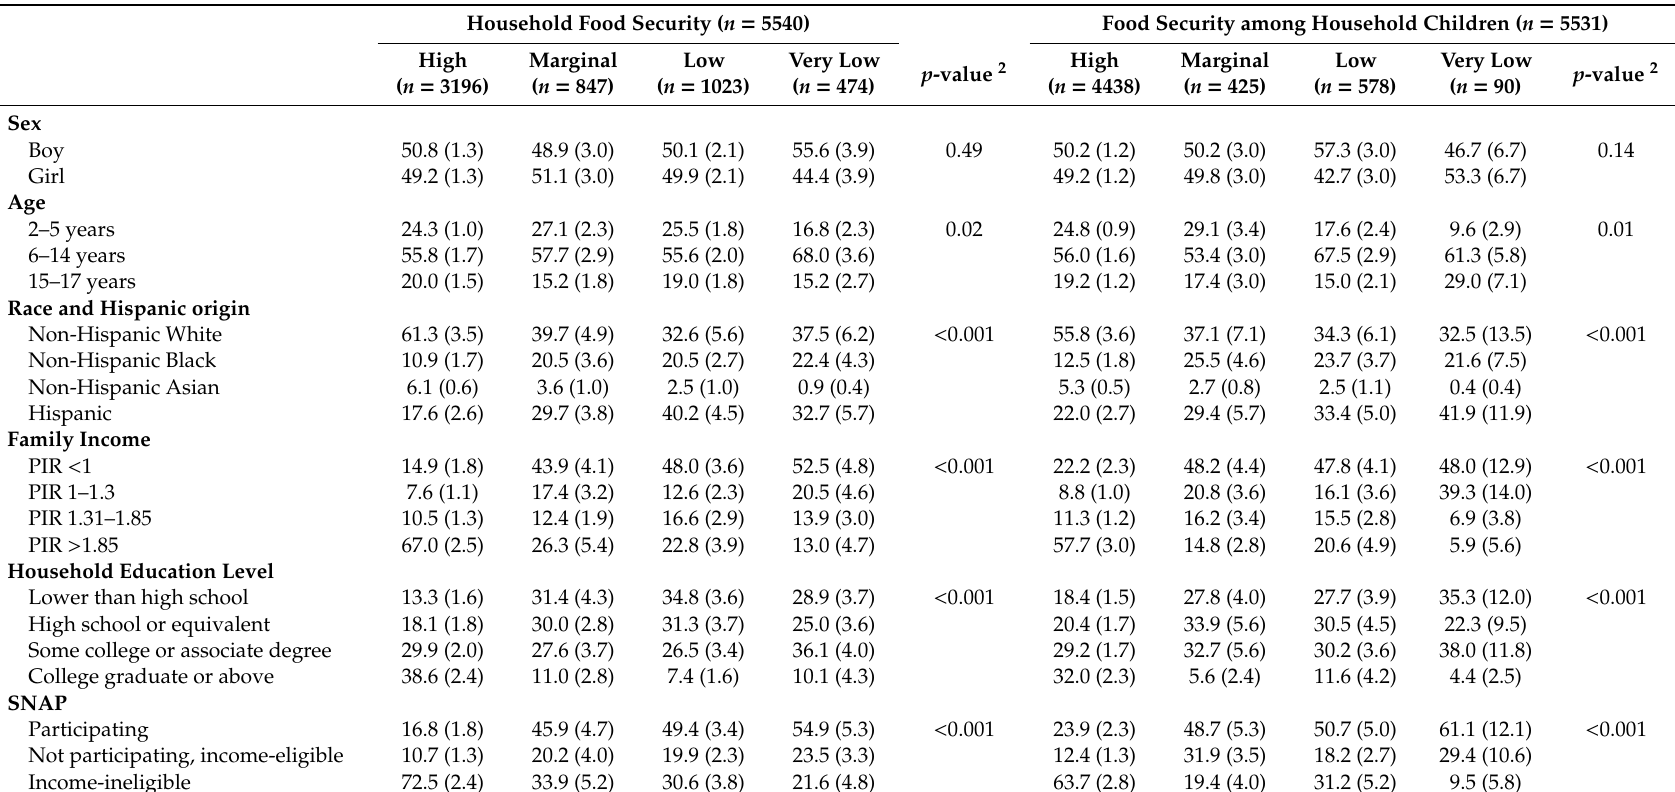
Table 1. Sociodemographic characteristics of U.S. children (2–17 years) by household food security and food security among household children 1 . Household Food Security ( n =